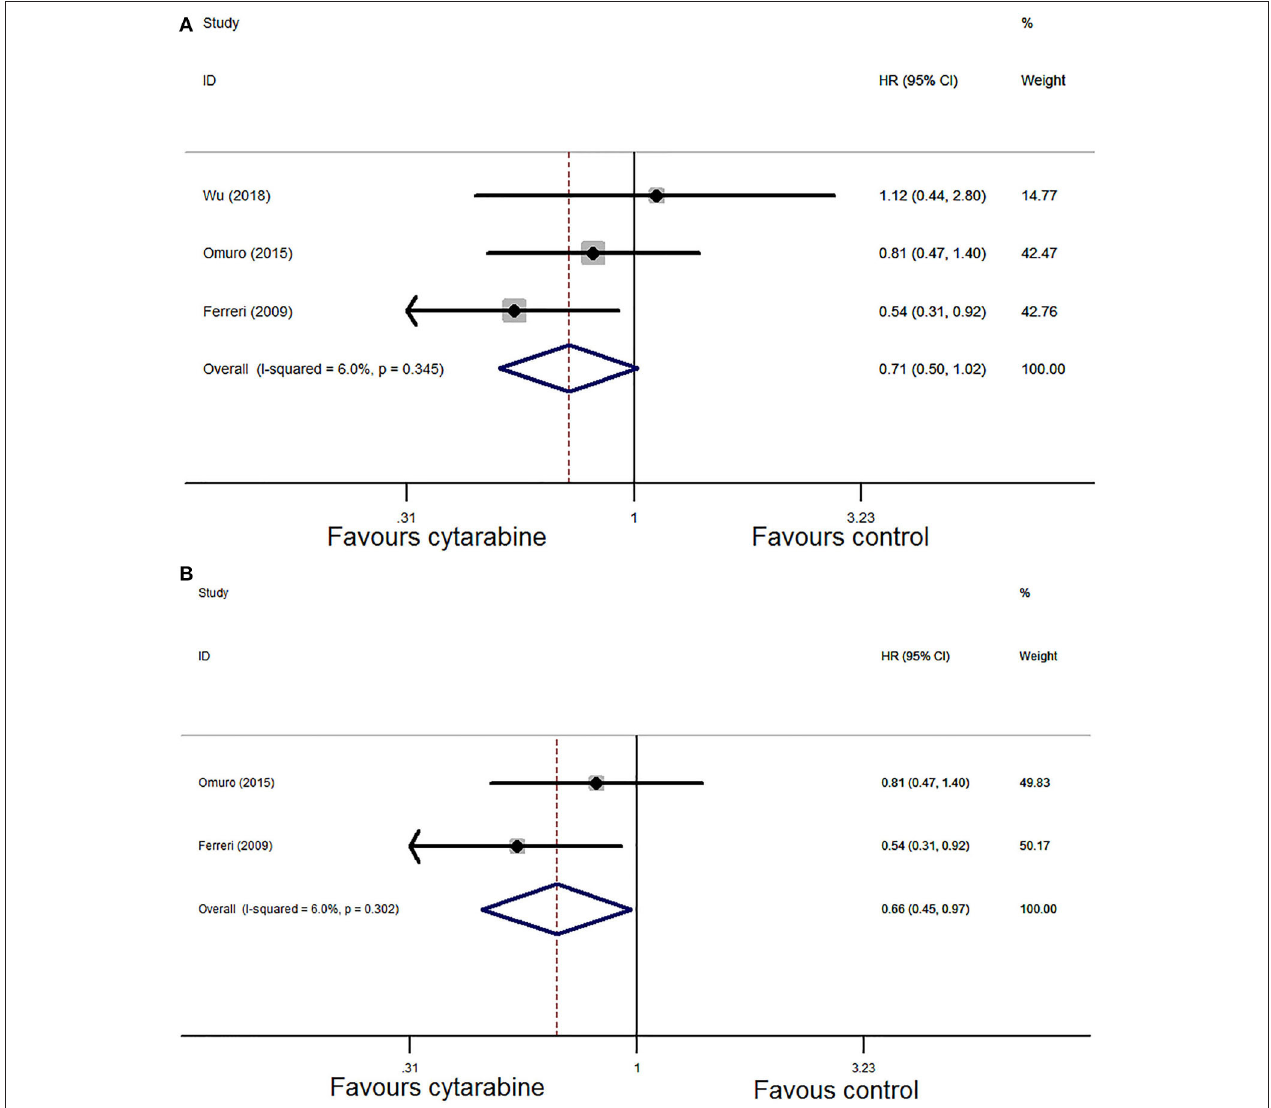
FIGURE 6 | (A) Forest plot of progression-free survival for treatment with the cytarabine group vs. the cytarabine-free group (fixed effect model). HR is the effect size. (B) Forest plot of progression-free survival after deleting one study (fixed effect model). HR is the effect